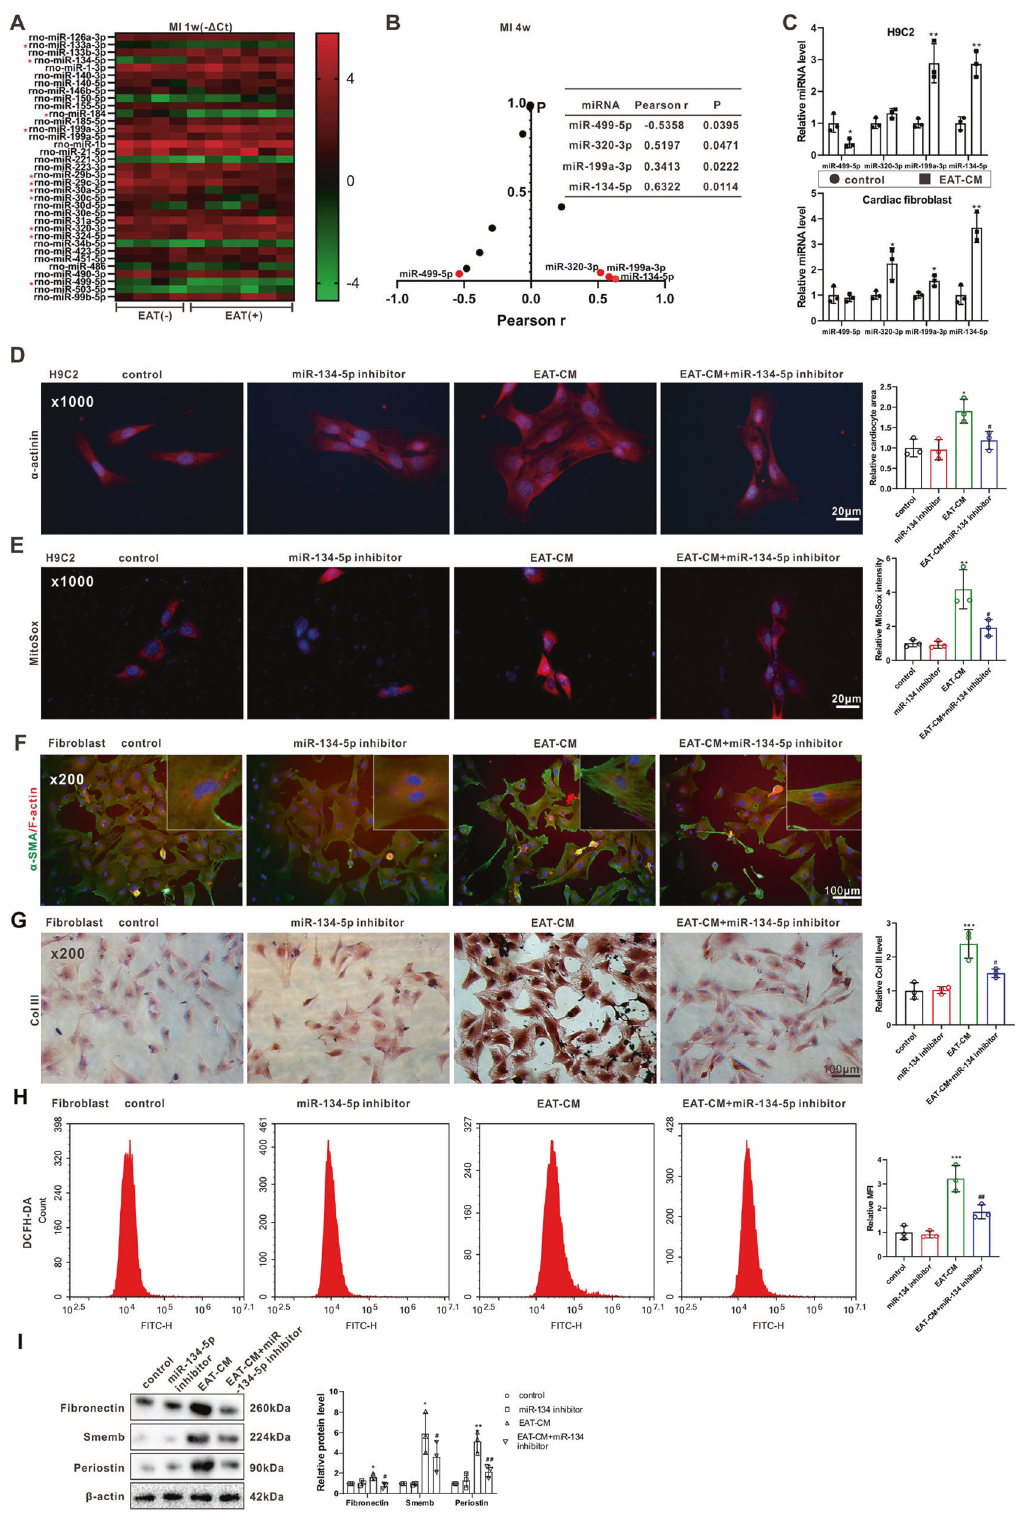
con fi rmed that secretory products from EAT promoted cardi- omyocyte hypertrophy and cardiac fi broblast activation by upregulating the ROS